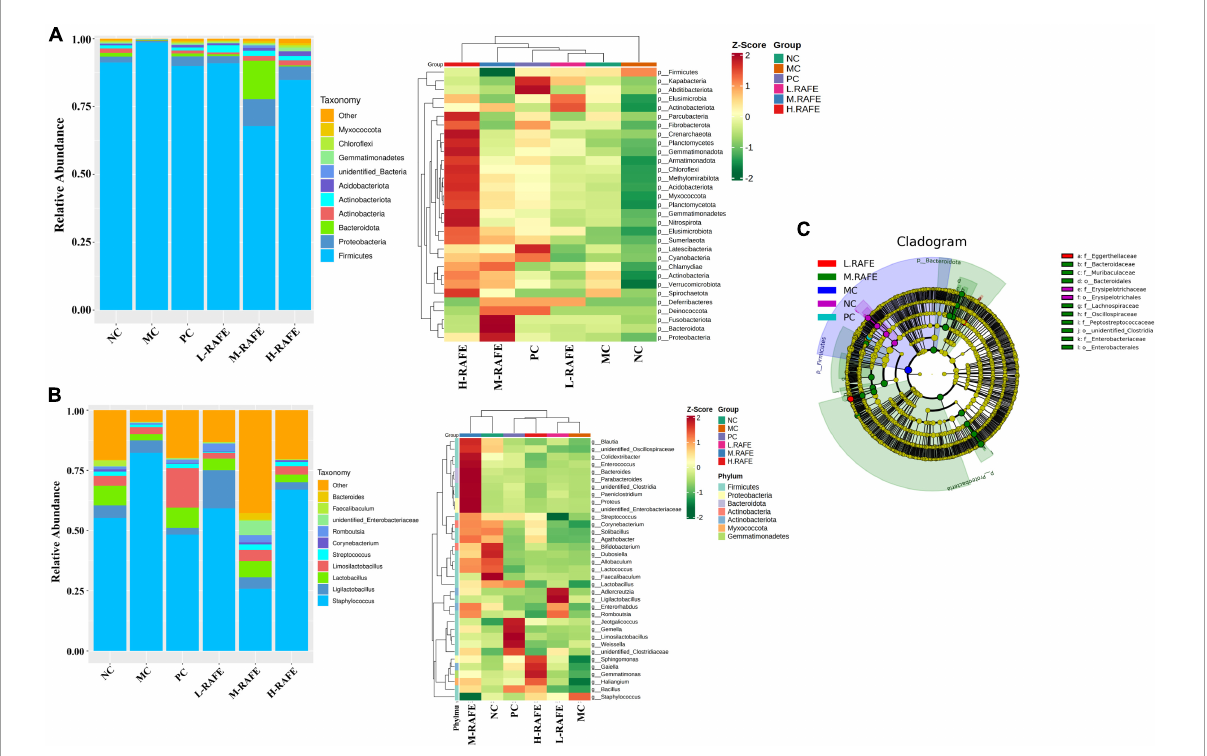
FIGURE8 Effect of RAFE on species abundance at different taxonomic levels of mice intestinal microorganisms and linear discriminant analysis effect size. (A) Abundance chart at the gate level, with a stacked bar diagram of relative species abundance at the gate level on the left and a heat map of species abundance at the gate level for the top 35 microorganisms on the right, (B) abundance chart at the genus level, with a stacked bar diagram of relative species abundance at the genus level on the left and a heat map of species abundance at the genus level for the top 35 microorganisms on the right, and (C) evolutionary branching diagram, where the circles radiating from interior to exterior represent the taxonomic level from phylum to genus or species. Each small circle at different taxonomic levels represents a taxon at that level, and the diameter of the small circles is proportional to the relative abundance size. Coloring principle: species with no significant differences are uniformly colored yellow, and species with differences follow the group for coloring. n = 3